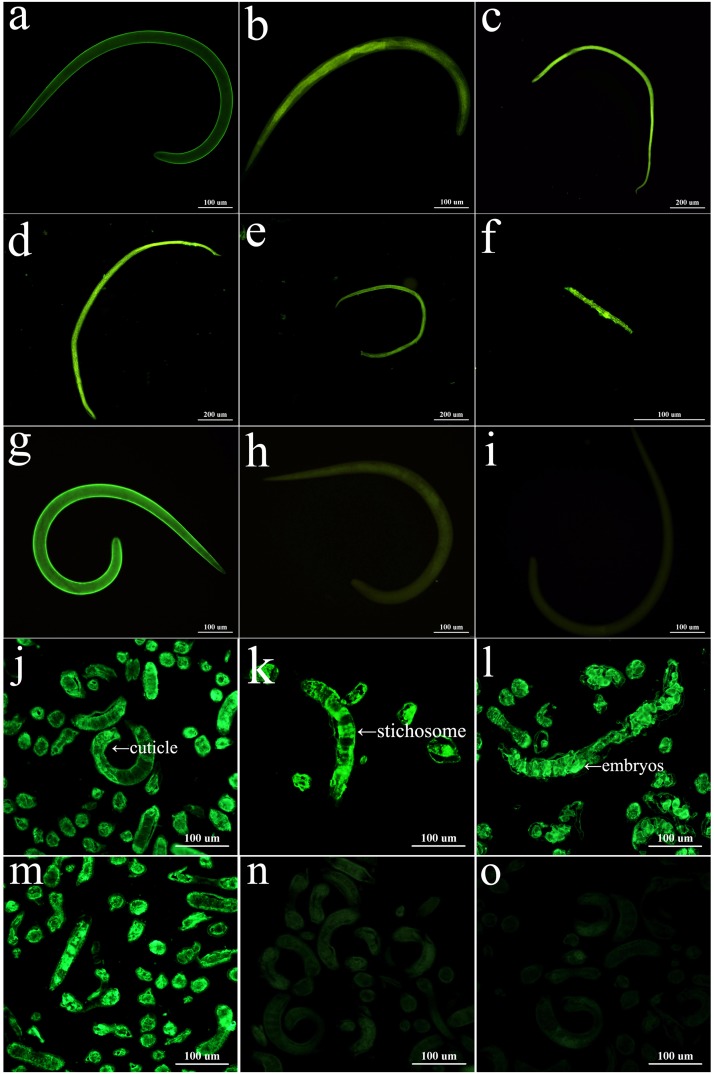
Expression and immunolocalization of TsSPI in different T. spiralis phases. (a–i) The intact worms were examined by IFA with different mouse sera. When the anti-rTsSPI serum was used, immunostaining was observed on the surface of ML (a), IIL (b), 3-day female adult (c), 6-day female (d), 6-day male adult (e), and NBL (f). ML recognized by infection serum (g) was used as a positive serum control; ML incubated using pre-immune serum (h) and PBS (i) were used as negative serum and blank controls. (j–o): Worm sections were examined by IFA with different mouse sera. The worm sections were probed by anti-rTsSPI serum, intense fluorescent staining is observed in cuticles, stichosome of ML (j), IIL (k), and embryos of 3-day female adult (i). The ML reacted by infection serum (m) was used as a positive serum control; there are no staining in the ML with pre-immune serum (n) and PBS (o) as a negative control. Scale-bars: 100 μm.